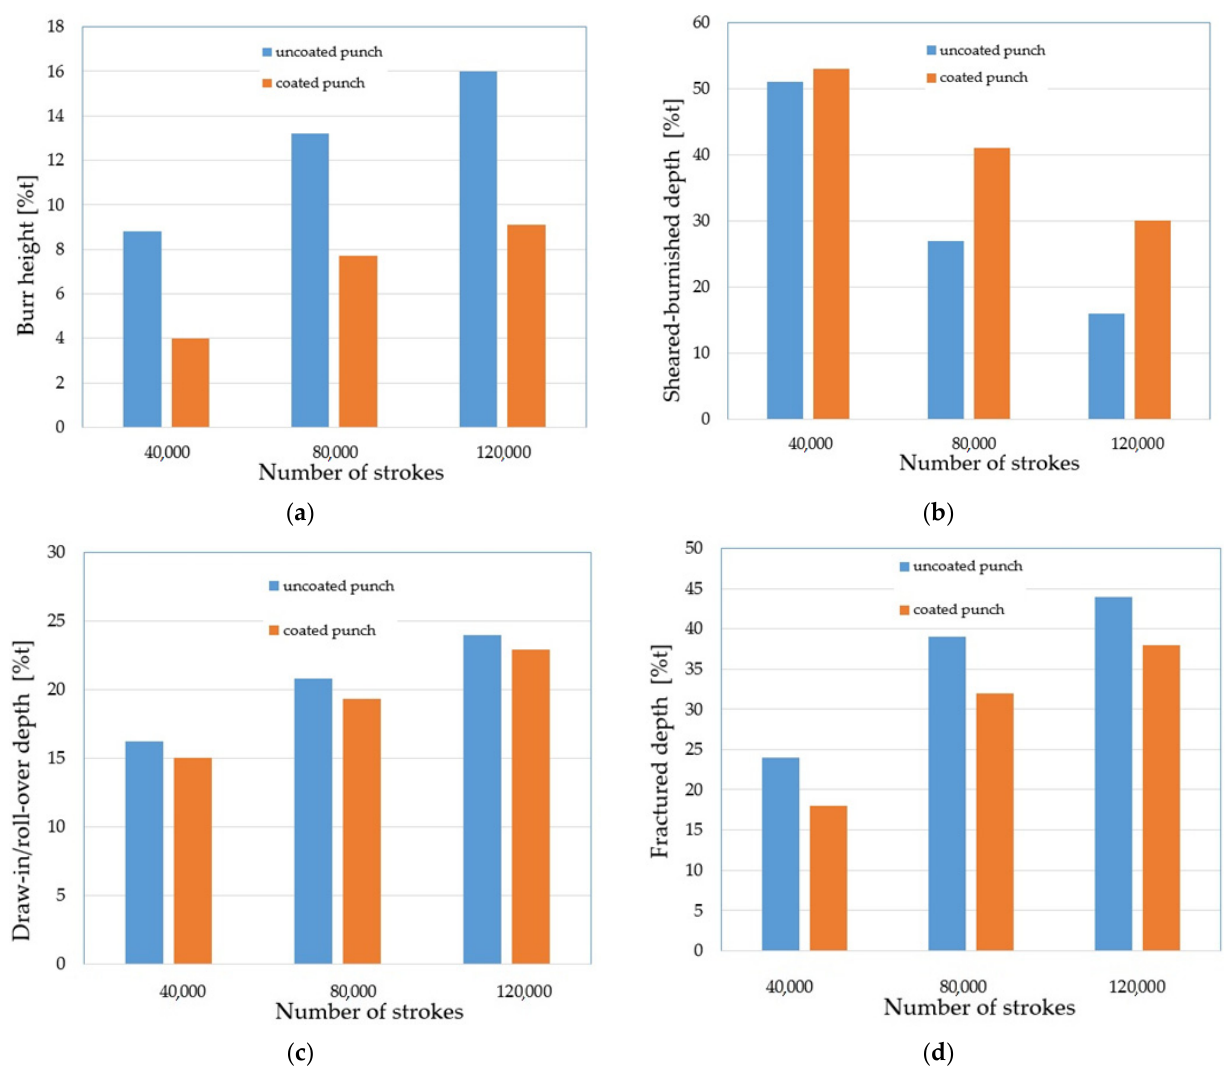
Figure 17. Average values of the cut surface zones for uncoated and coated punches: ( a ) burr height; ( b ) sheared–burnished; ( c ) draw-in/roll-over; ( d ) fractured.